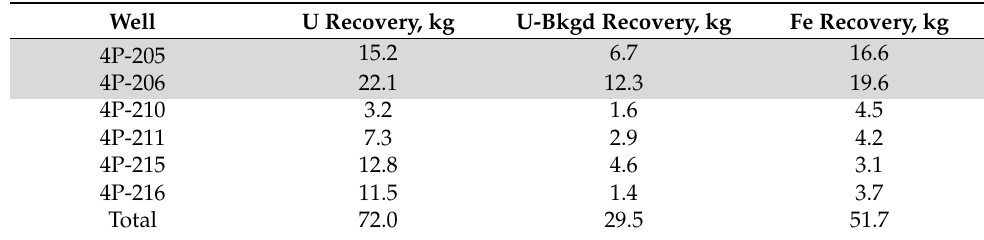
Table 3. Mass recoveries of uranium and iron in each of the production wells. Total recoveries are listed in the last row of the table. “U-bkgd” is the U recovery in excess of what would have been recovered if the concentrations in all wells had remained at their pre-test levels throughout the test. Shaded rows indicate well patterns receiving